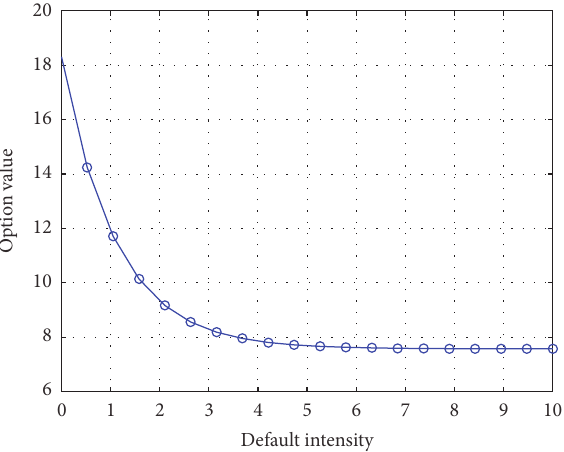
Figure 4: Option value with different default intensity.